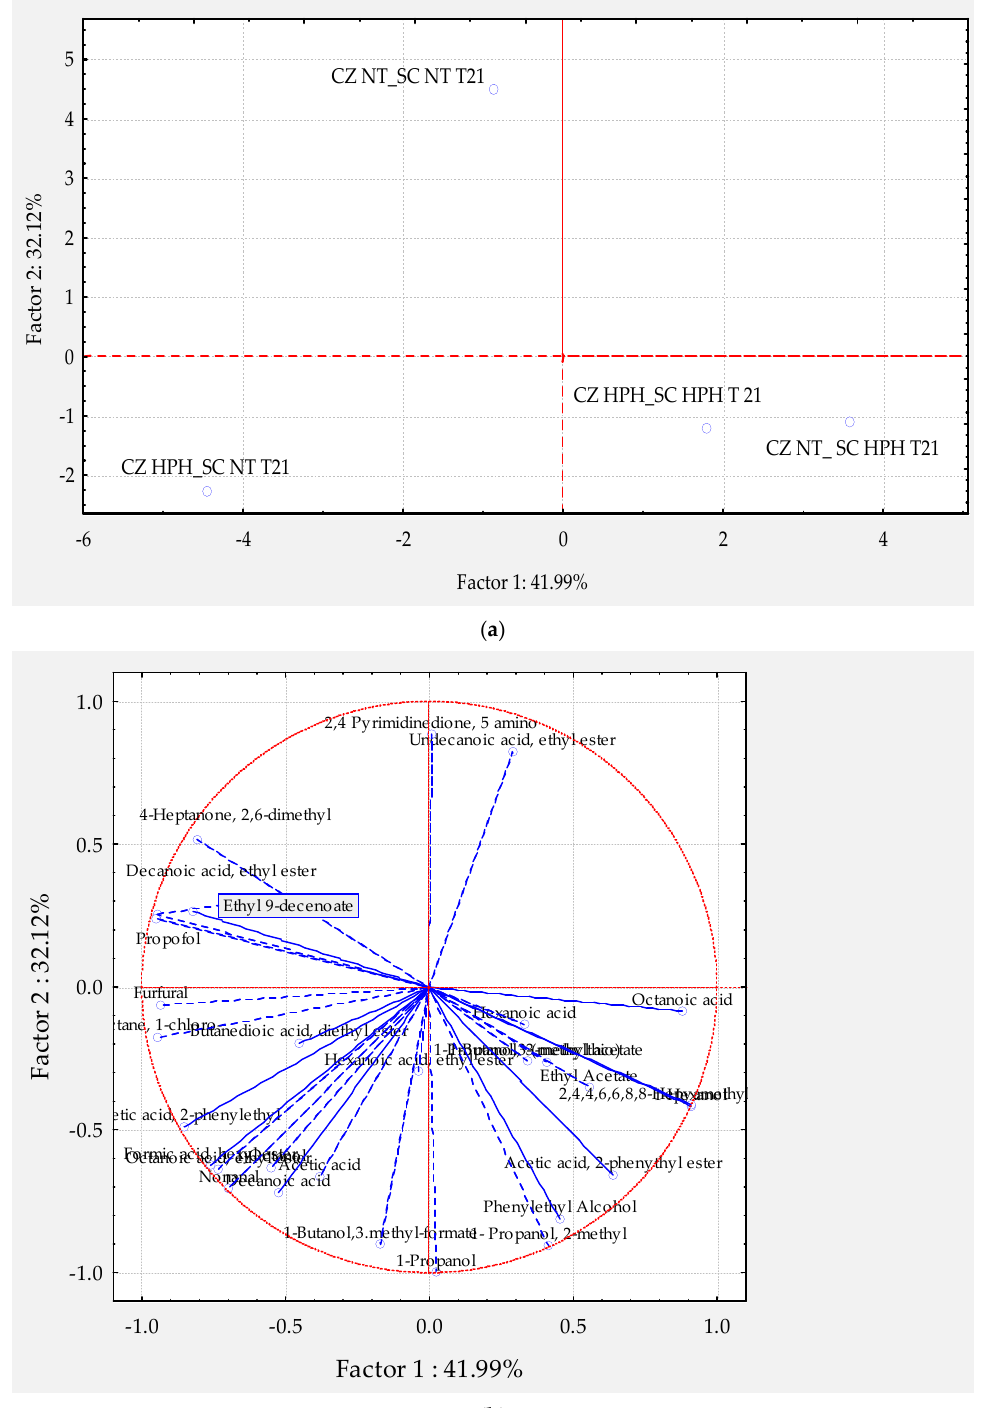
Figure 5. ( a ) Principal component analysis loading plot (PCA) of the PC1 and PC2 of wine samples volatile aroma profiles obtained by scalar fermentation of a wild strain of Candida zemplinina (CZ) and a commercial strain of S. cerevisiae (SC) after 21 days of fermentation and in relation to the initial HPH treatment; ( b ) Principal component analysis factor coordinates (volatile compounds) mapped in the space described from PC1 and PC2, accounting respectively, the 41.99% and 32.12%, variance among samples observed.